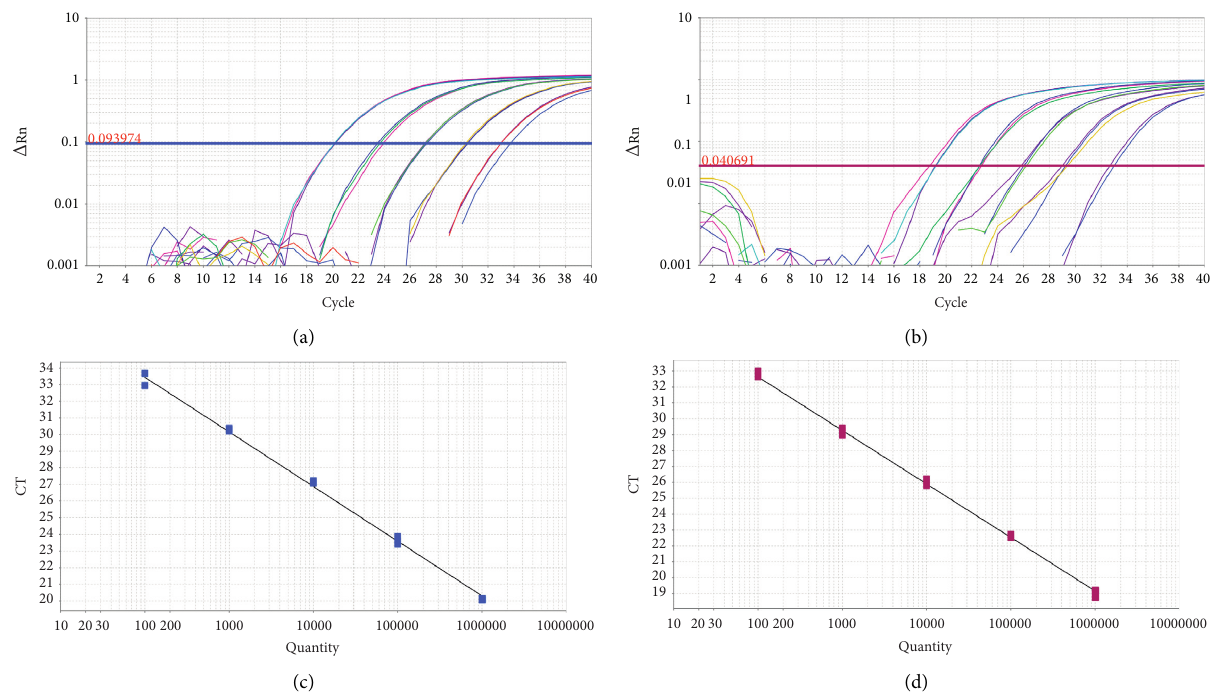
Figure 3: Calibration curves for P-35S and NR in qPCR. The dilutions contained approximately 10 6 , 10 5 , 10 4 , 10 3 , and 10 2 copies per PCR. (a) Amplification plot of P-35S . (b) Amplification plot of NR . (c) Standard curve of P-35S ( y � − 3.288 x +40.022, R 2 � 0.997, Eff% � 101.427). (d) Standard curve of NR ( y � − 3.37 x +39.38, R 2 � 0.998, Eff% � 98.036). Table 2: Repeatability and reproducibility of the pGMT27 plasmid as a calibrator in qPCR. Ct